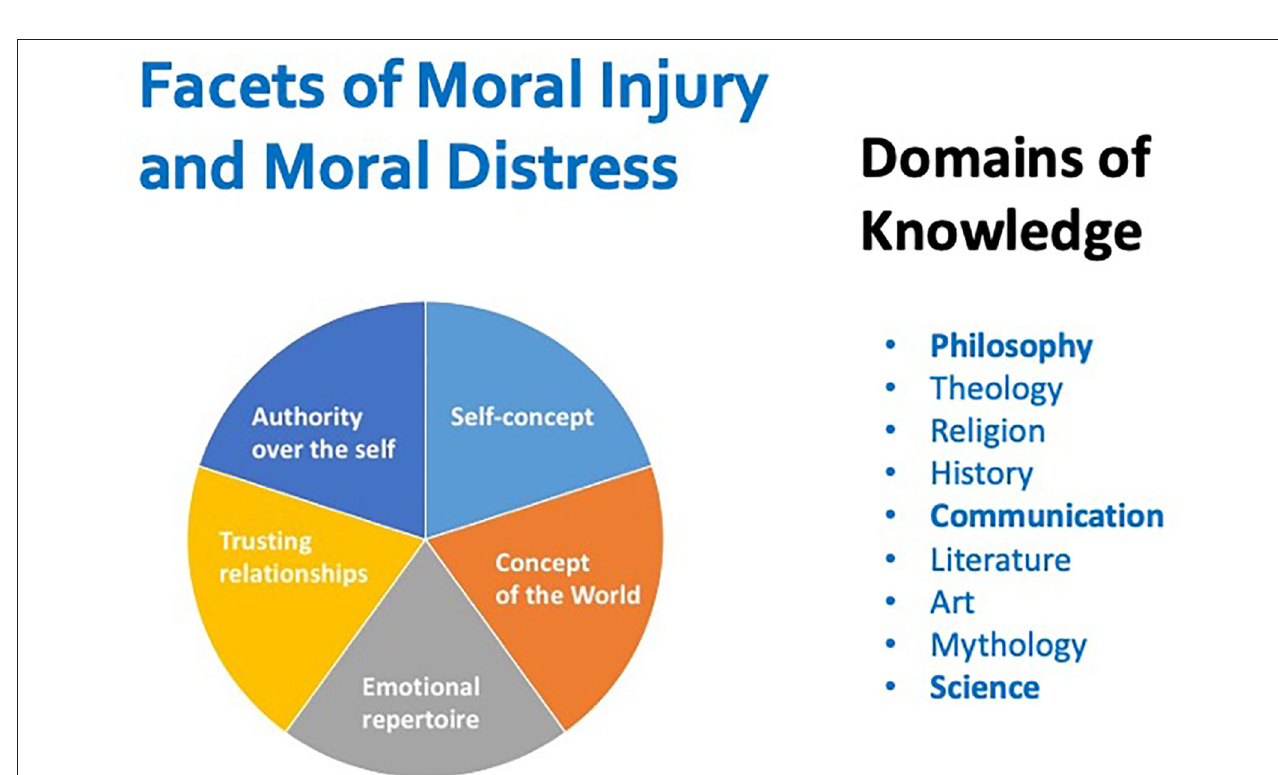
FIGURE 2 | Domains and impact of moral injury.